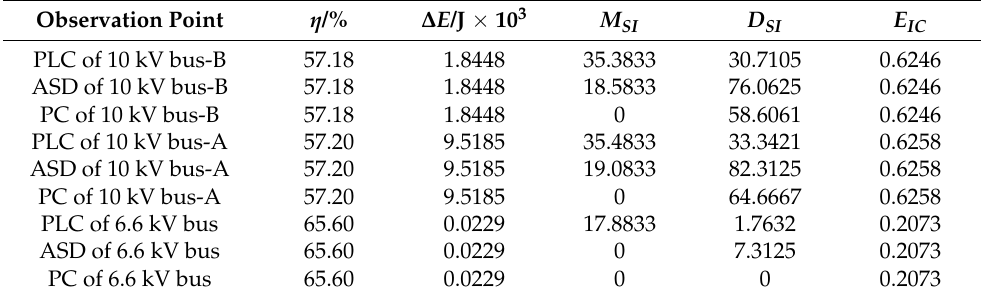
Table 4. Index value of SPSF.